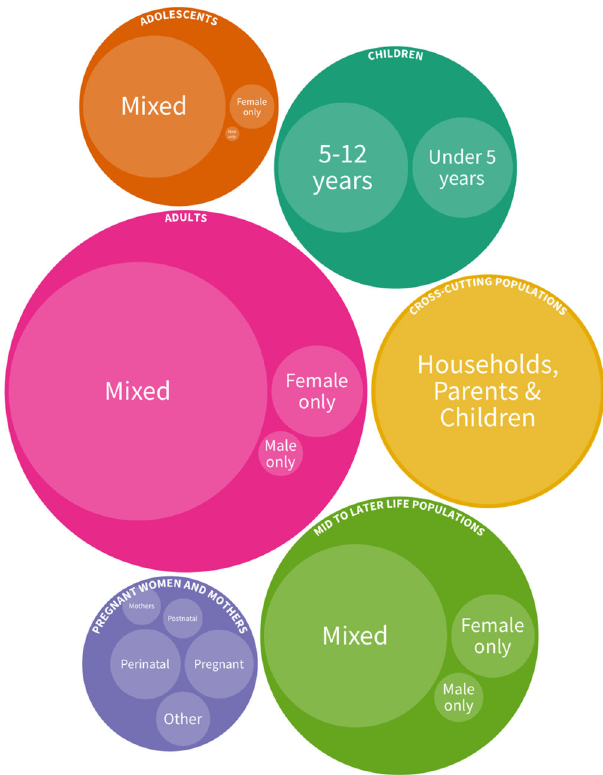
Fig. 6 | Nested bubble diagram showing the frequency of study population groups in which FSN and mental health linkages are investigated. Bubbles are proportionaltothefrequencyofanalysesbasedoneachpopulationgroup.Bubbles for ‘ Children ’ ( n =257), ‘ Adolescents ’ ( n =214), ‘ Pregnant Women and Mothers ’ ( n =149), ‘ Adults ’ ( n =735)and ‘ MidLaterLifepopulations ’ ( n =408)refertostudies in which the relationship between FSN and mental health is examined within the same study population group. The bubble for ‘ Cross-cutting populations ’ shows studiesinwhichtheFSNmeasureinonegroupishypothesizedtoaffectthemental health of another group or vice versa, this includes interactions between house- holds, parents, and/or